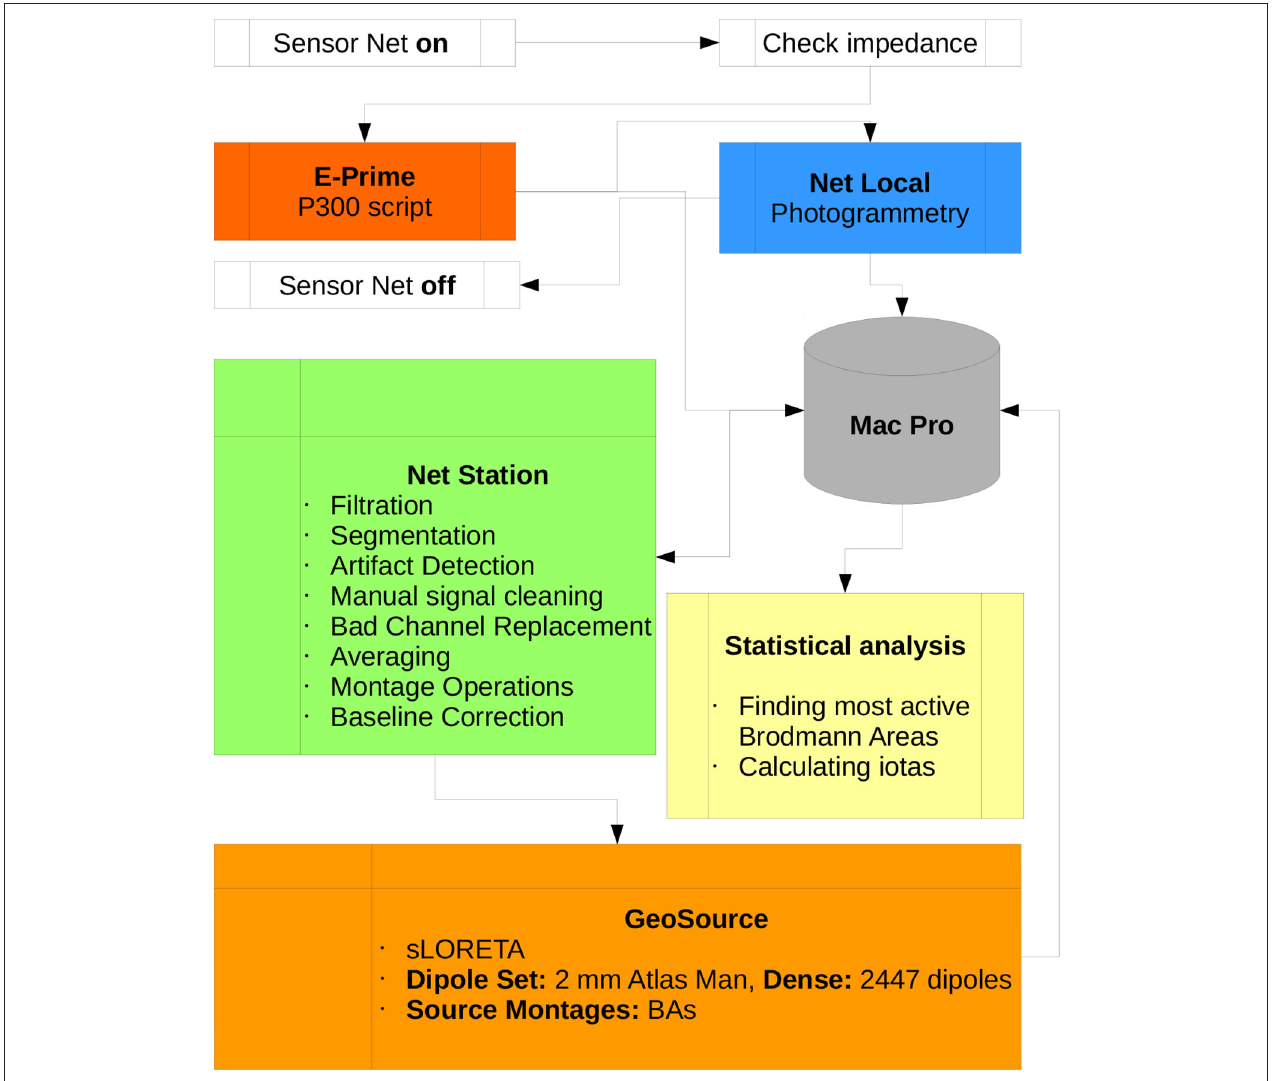
FIGURE 4 | Diagram of the P300 research protocol proposed in this paper. Participation of the subject in the experiment begins when the Sensor Net is put on and ends when it is taken off. All data is collected by the Mac Pro workstation which is the central part of the lab. All scripts used for preprocessing data in Net Station and postprocessing in GeoSource are listed. Statistical analysis, finding the most active BAs and calculating ι for each of them can be conducted using other